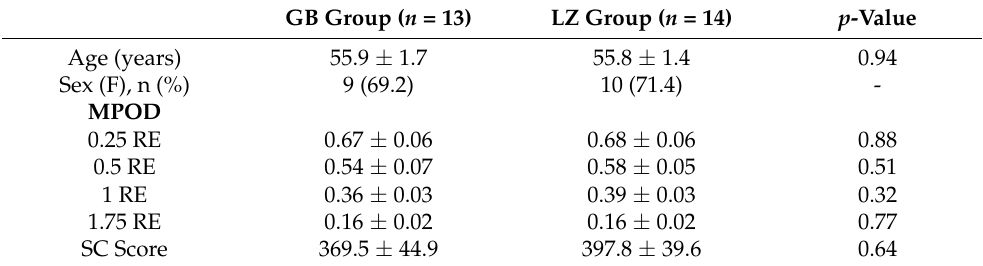
Table 3. Baseline measurements of participants in the goji berry (GB) and the lutein and zeaxanthin supplement (LZ)